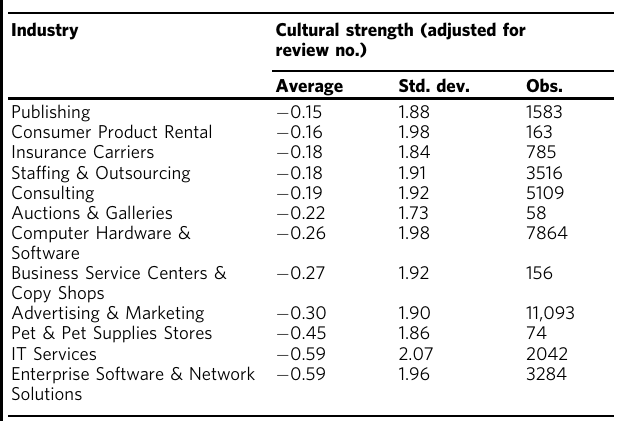
Table 7, all the satisfaction variables exhibit negative excess